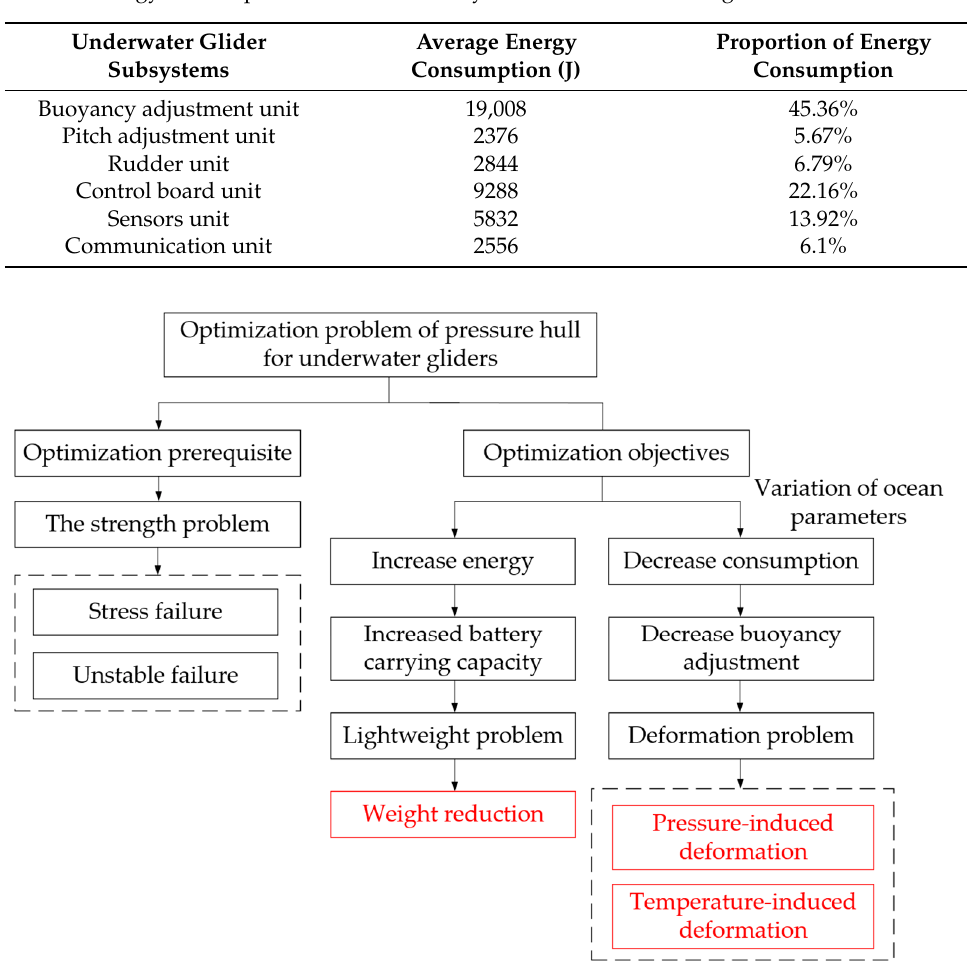
Table 1. Energy consumption data of each subsystem of the underwater glider.